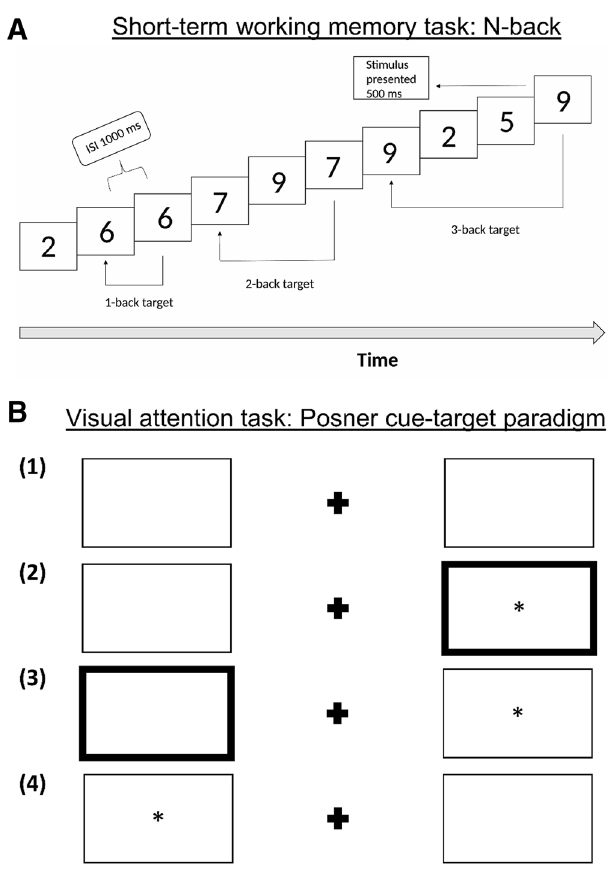
Figure 3. Schematic representation of the cognitive tasks. ( A ) The N-back task for working short-term memory. Sixty-three digits were presented one at a time for each session of one working memory load condition, which varied from 1-back (least difficult) to 3-back (most difficult). Each stimulus was presented for 500 ms with an inter-stimulus-interval of 1000 ms. ( B ) The Posner cue target task for visual attention. (1) Screen appearance prior to cue presentation and stimulus appearance—central cross with rectangles to the right and left. (2) Valid cue presentation—borders thicken (cue) prior to target stimulus appearance inside the rectangle. (3) Invalid cue presentation—target stimulus appears opposite to cue rectangle. (4) No cue presentation prior to target stimulus